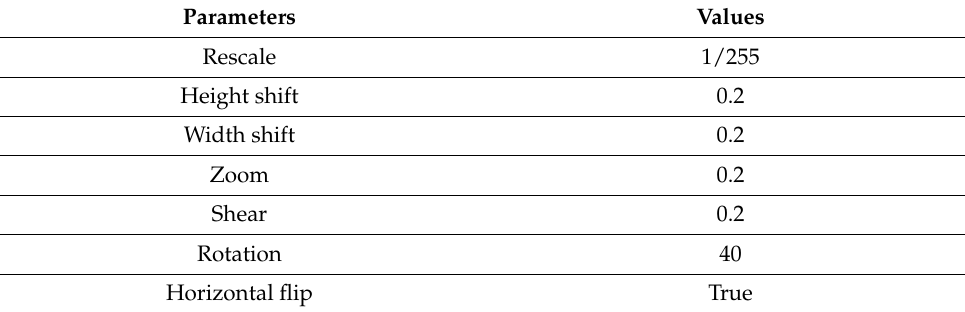
Table 1. Augmentation parameters set for the generating images.